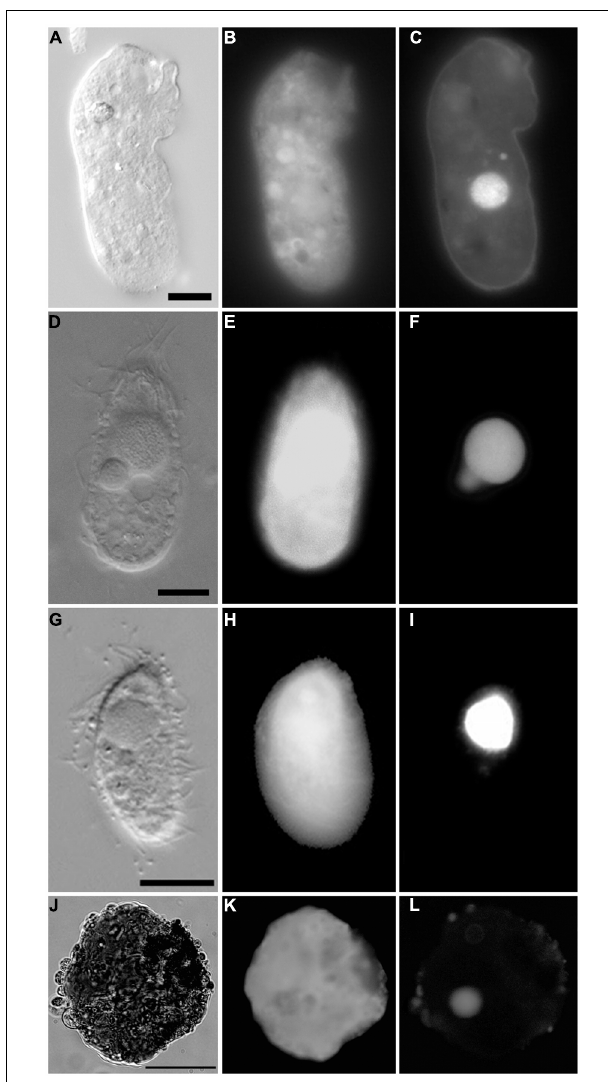
FIGURE 8 | Light micrographs of protists incubated in both CellTracker Green and DAPI. (A–C) Specimen from 607-608 cB (Urania control); paired images showing DIC (A) and epifluorescence (B,C) of CellTracker Green labeling (B) and DAPI (C) staining. Note the fluorescence of the cytoplasm, the nucleus (C) , and absence of abundant associated prokaryotes. (D–F) Ciliate from 607-608 cE (Urania halocline); paired images showing DIC (D) and epifluorescence (E,F) of CellTracker Green labeling (E) and DAPI (F) staining. Note fluorescence of the cytoplasm, the macronucleus, and micronucleus (F) and lack of prokaryotic associates. (G–I) Ciliate from 609-610 cH (Discovery upper halocline); paired images showing DIC (G) and epifluorescence (H,I) of CellTracker Green labeling (H) and DAPI (I) staining. Note the lack of prokaryotic associates. (J–L) Unidentified protist from 609-610 cL (Discovery lower halocline). Note the nucleus and scattered bacteria on exterior. Scales: A,G = 10 μ m, D = 100 μ m, J = 50 μ